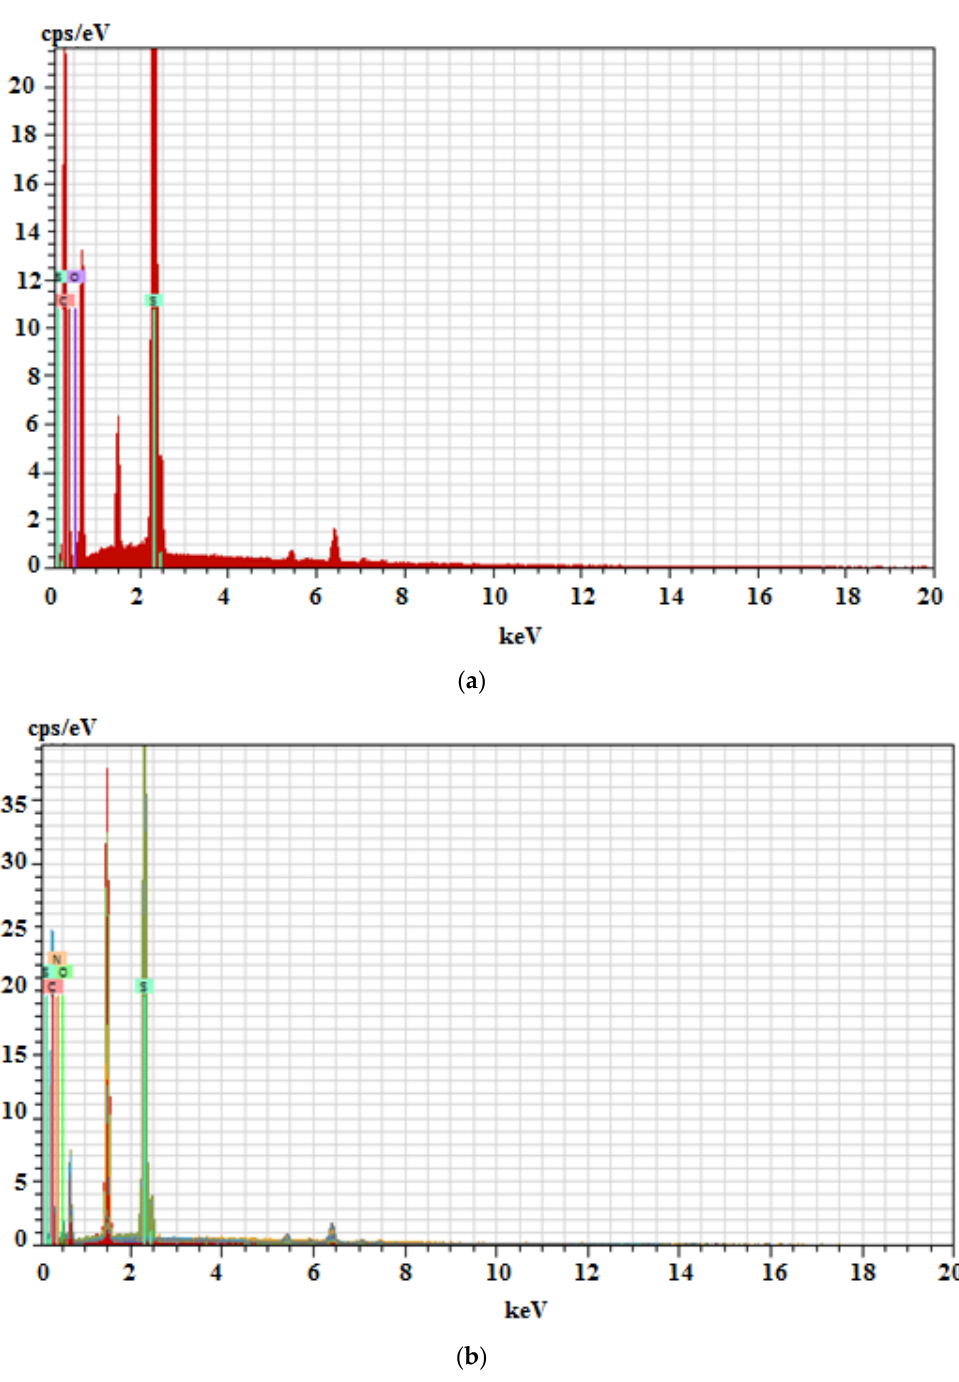
Figure 3. EDX chemical analysis of the poly (3-methylthiophene) surface without ( a ) and with imprinted drug molecule (for AMOX) ( b ).